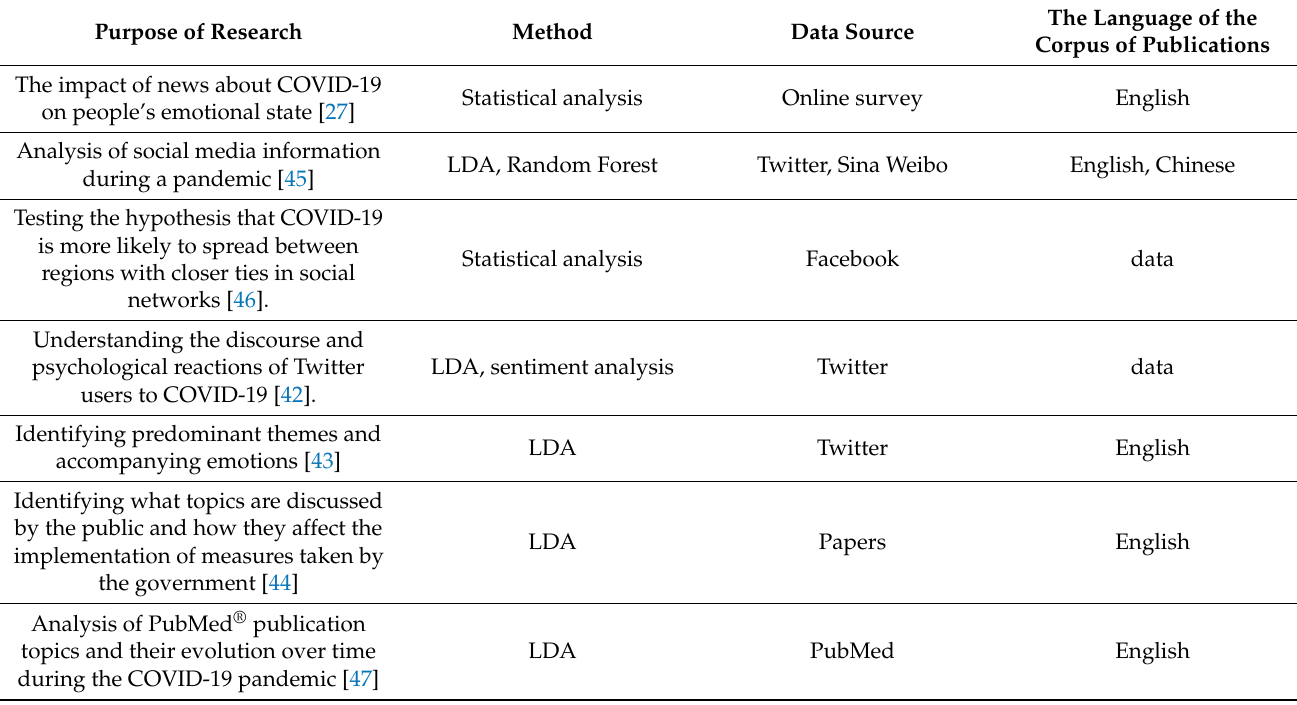
Table 1. Some examples of objectives and methods of research of publications about